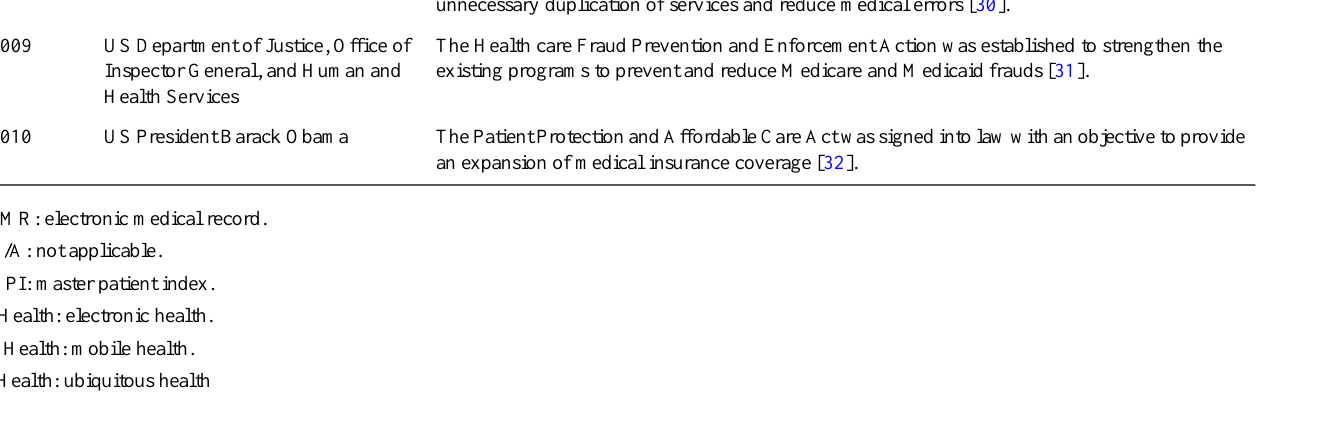
Table 2. Limitations of health data management